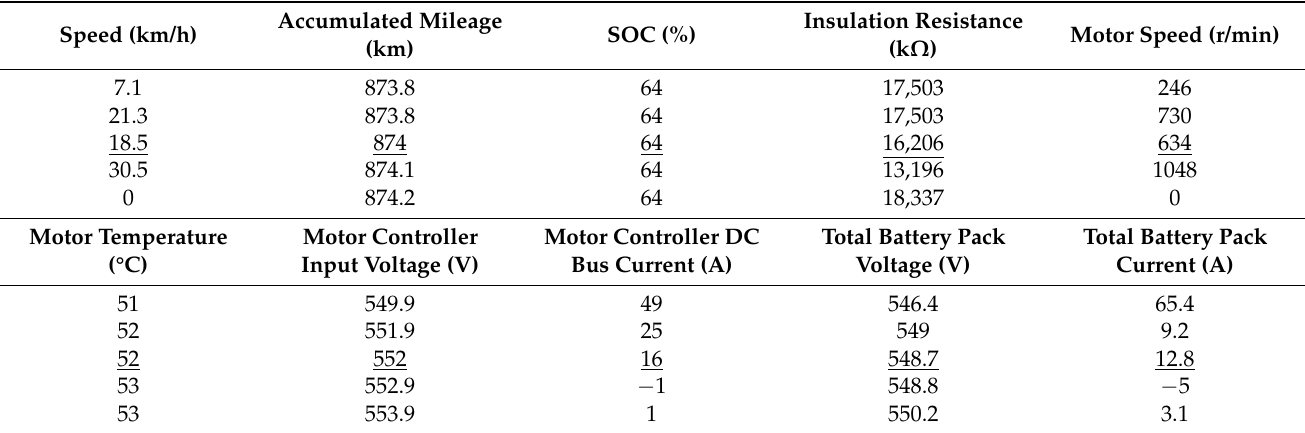
Table 2. Short-term missing data